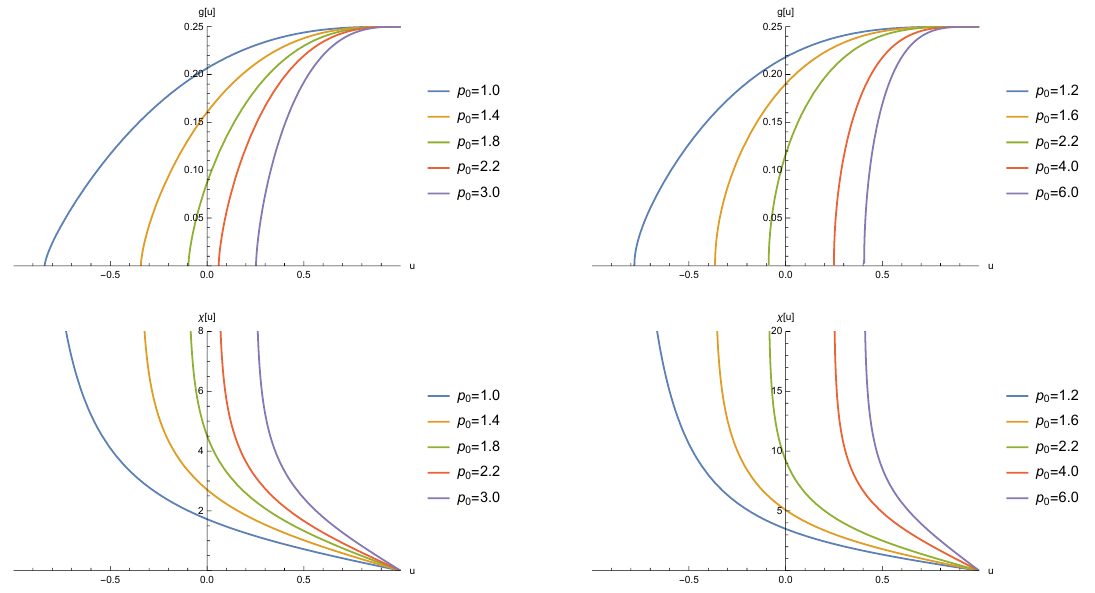
Figure 8 . Massless solutions for d = 3 (left) and d = 4